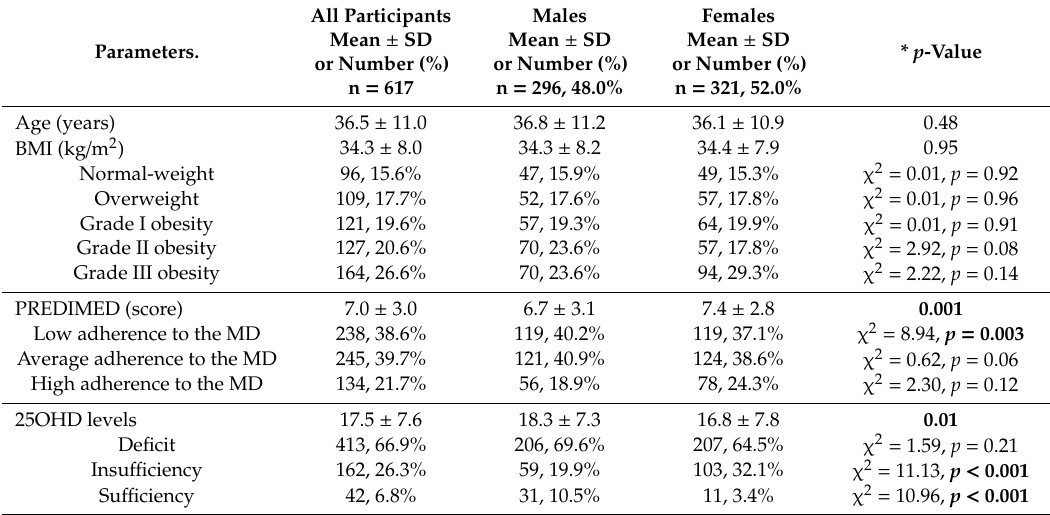
Table 1. Age, anthropometric characteristics, adherence to the MD, and 25OHD levels in the whole study population and stratified by gender.